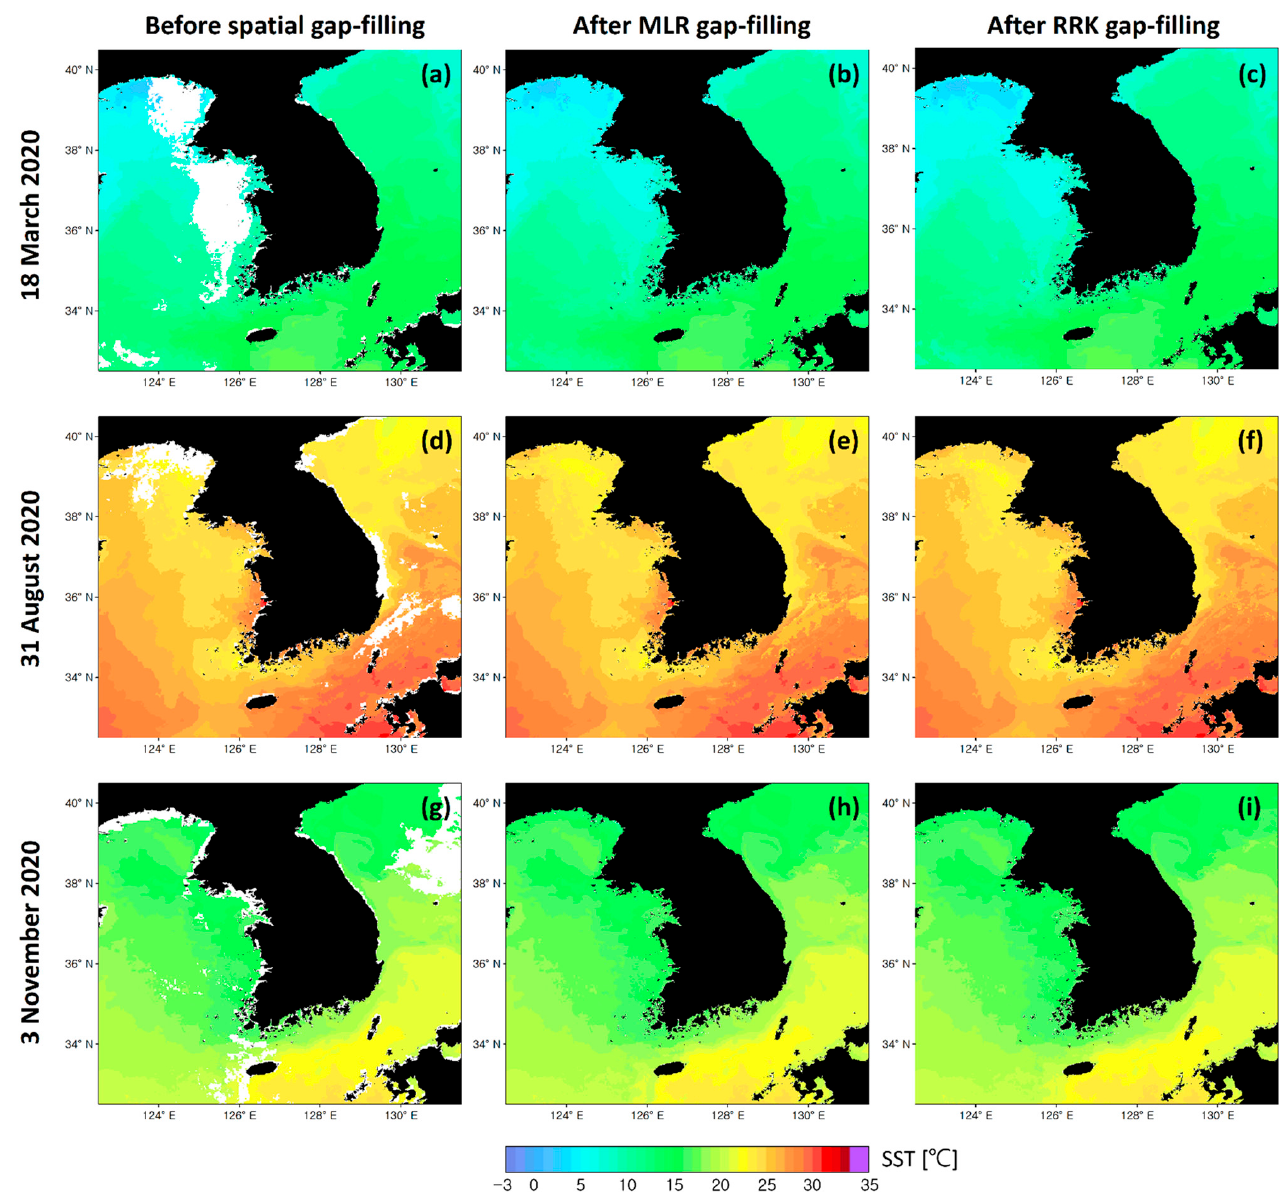
Figure 14. GK2A SST maps before and after the MLR and RRK gap-filling with the example of 18 March, 31 August, and 3 November, 2020. ( a , d , g ) denote images before spatial gap-filling. ( b , e , h ) gap-free SST after MLR, and ( c , f , i ) gap-free SST after RRK.